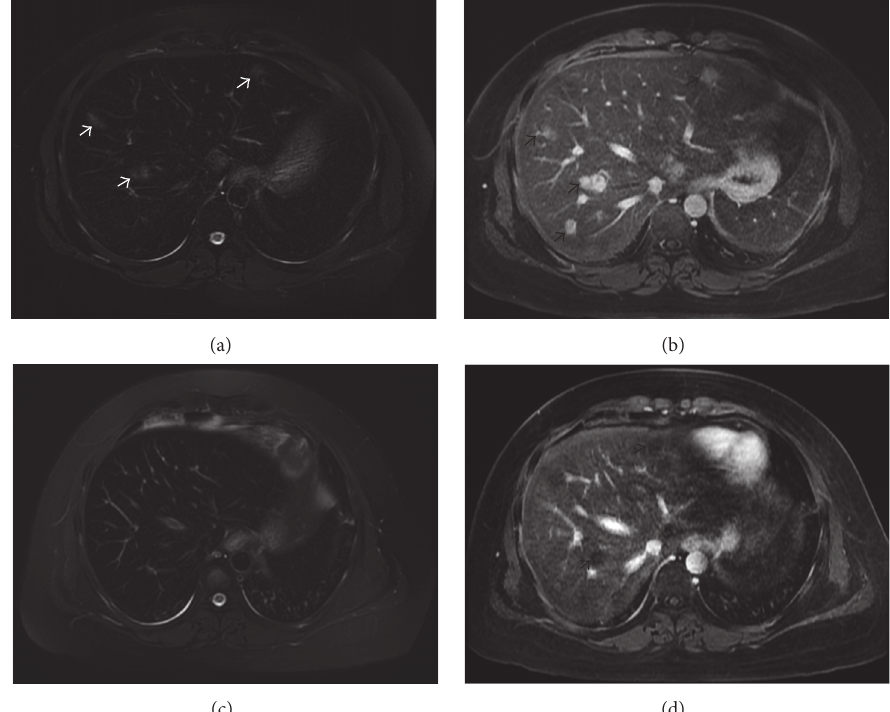
Figure 1: (a, b) Baseline MRI. (a) Axial T2-weighted fat saturated (T2W-FS) image shows faintly hyperintense lesions in the liver (white arrows). The liver parenchyma is hypointense and shows reduced signal in keeping with iron loading. (b) Axial delayed postcontrast T1W images show persistent delayed enhancement in the lesions (black arrows). (c, d) MRI after treatment. (c) Axial T2W-FS image shows that the lesions are isointense to the rest of the liver parenchyma which is hypointense (due to iron loading). The lesions are no longer hyperintense on the T2W-FS image. (d) Axial delayed postcontrast T1W images show that the lesions no longer show any appreciable